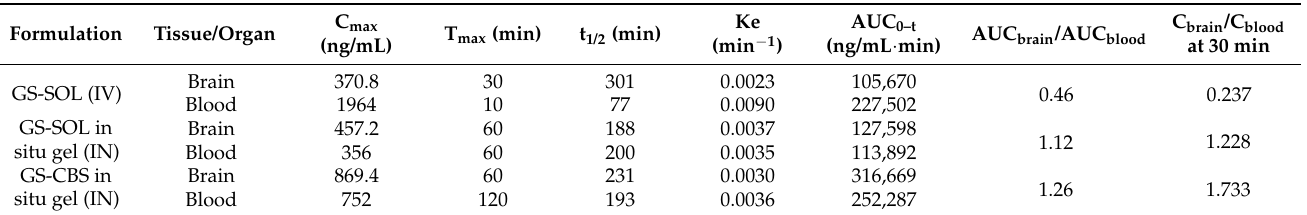
Table 5. Pharmacokinetic parameters of GS-CBS in situ gel (IN), GS-SOL in situ gel (IN), and GS-SOL